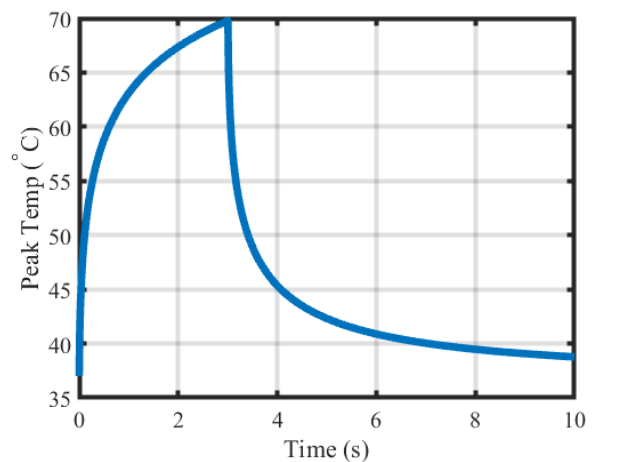
Figure 5. The temperature variation at the focus center during a sonication with t on = 3 s and t of f = 7